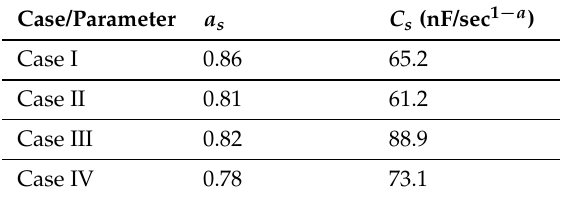
Table 12. Skin Cole parameters values for different cases, R o , s = 1.39 M Ω .